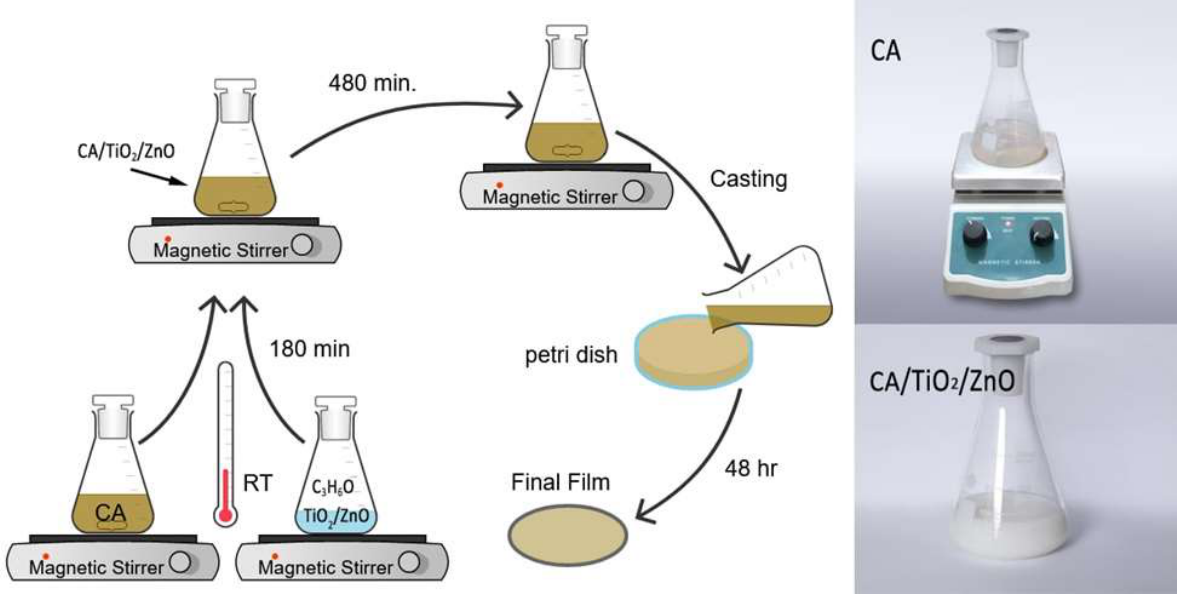
Figure 1: A schematic diagram of the preparation process for the films, on the right, the device used to prepare the compound (CA) and the final solution of the films (CA/TiO 2